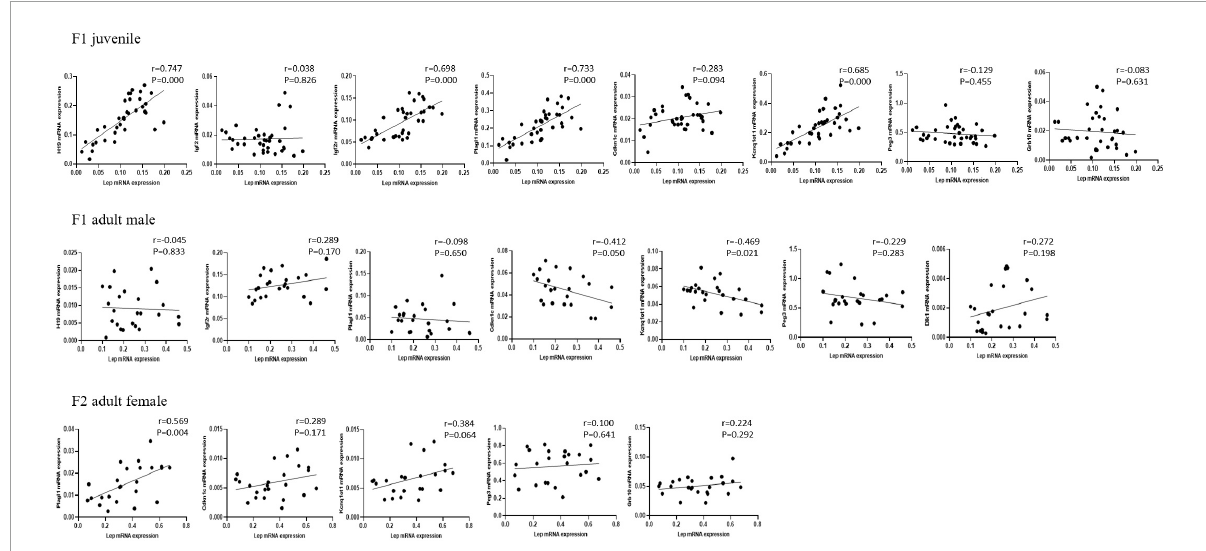
FIGURE5 Correlation between the expression of Lep and imprinted genes in the adipose tissue. The protocols for production of F1 and F2 offspring as well as the experiments were the same as those described in Figure 1 . Mice from the F1 and F2 offspring were fed normal chow diet for 16 weeks. Linear correlation analysis was performed to compare the expression of leptin (Lep) and other altered imprinted genes in juvenile F1 males and females, adult F1 males, and adult F2 females.